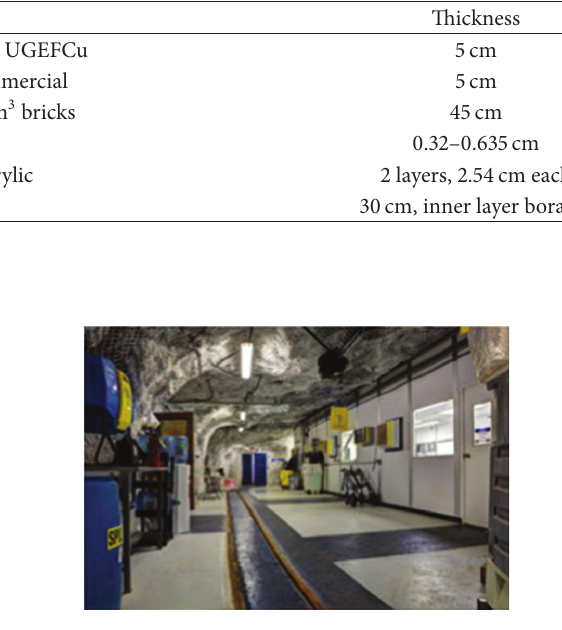
Figure 12: A photograph of the TCR used for electroforming on the 4850 󸀠 level at